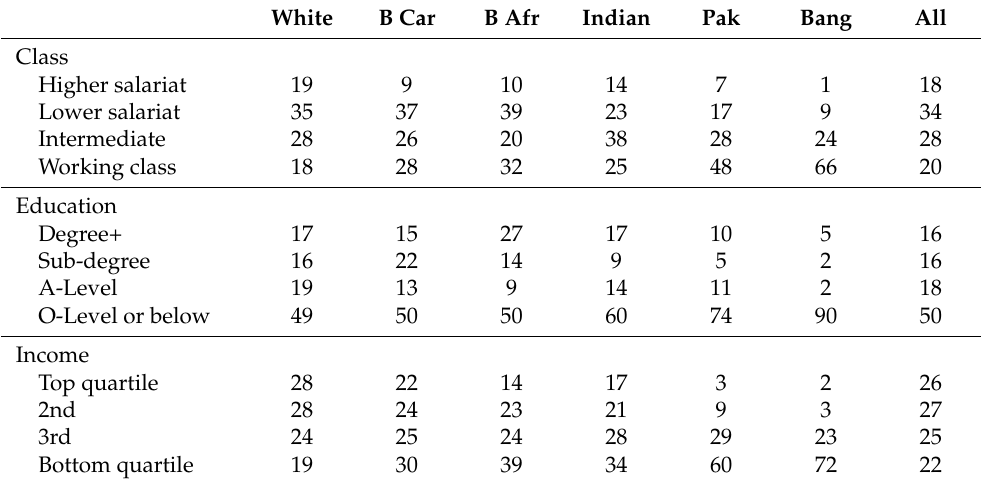
Table 2. Descriptive analysis of family origin characteristics (class, education and income) by ethnicity (column percentage within each panel).